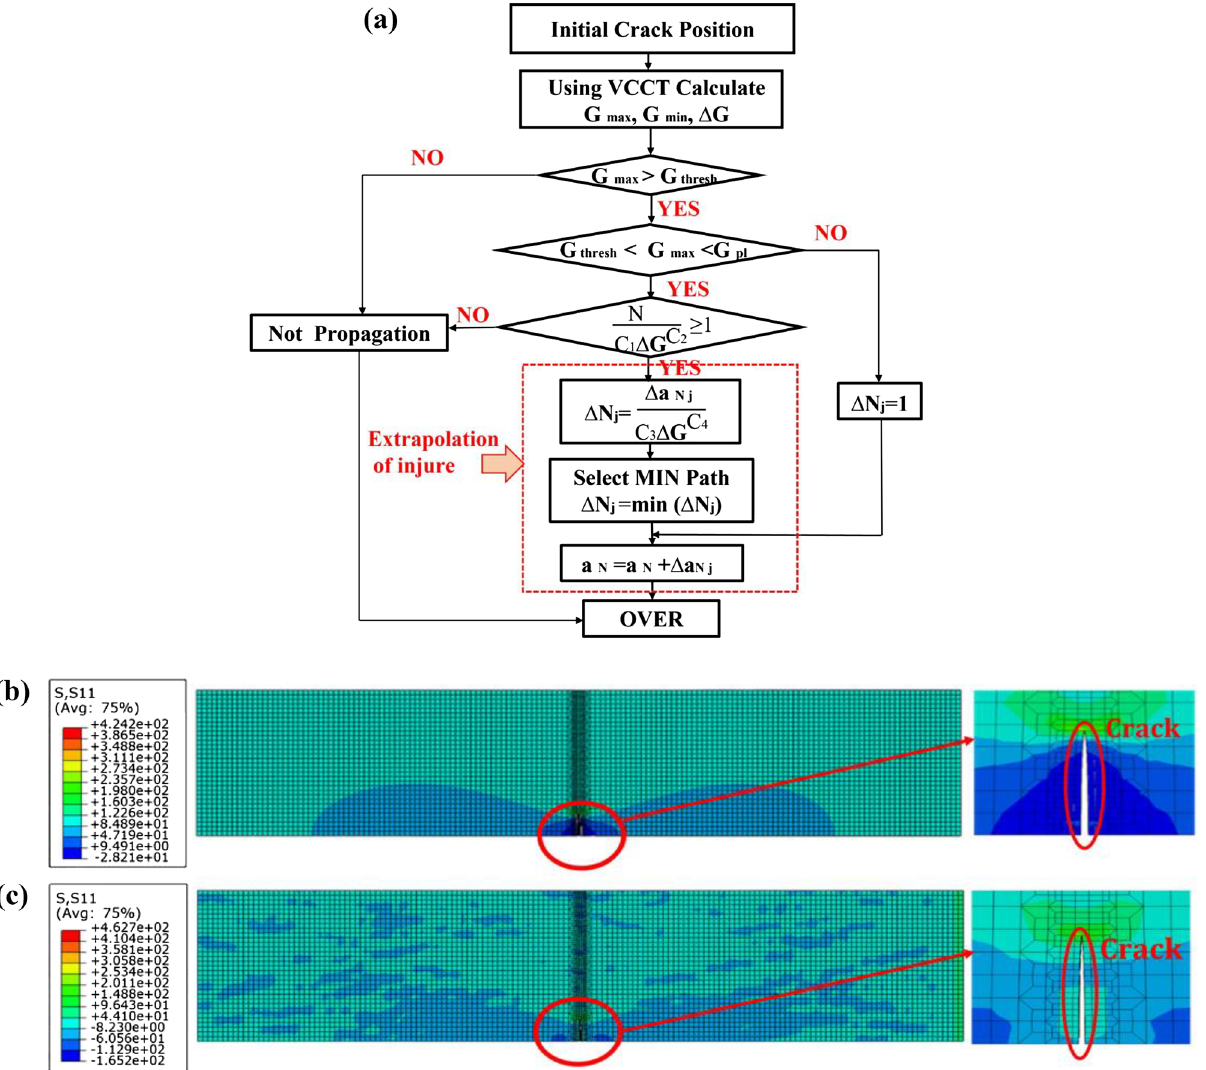
Figure 3. Crack growth finite element process and results: ( a ) Analysis process ( b ) MP Results; ( c ) S + F